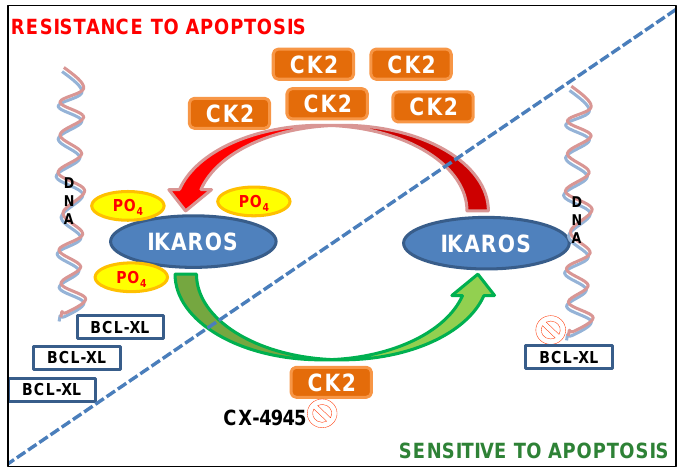
Figure 8. Model illustration of the regulation of apoptosis in AML by CK2 and IKAROS via repres- sion of BCL-XL.